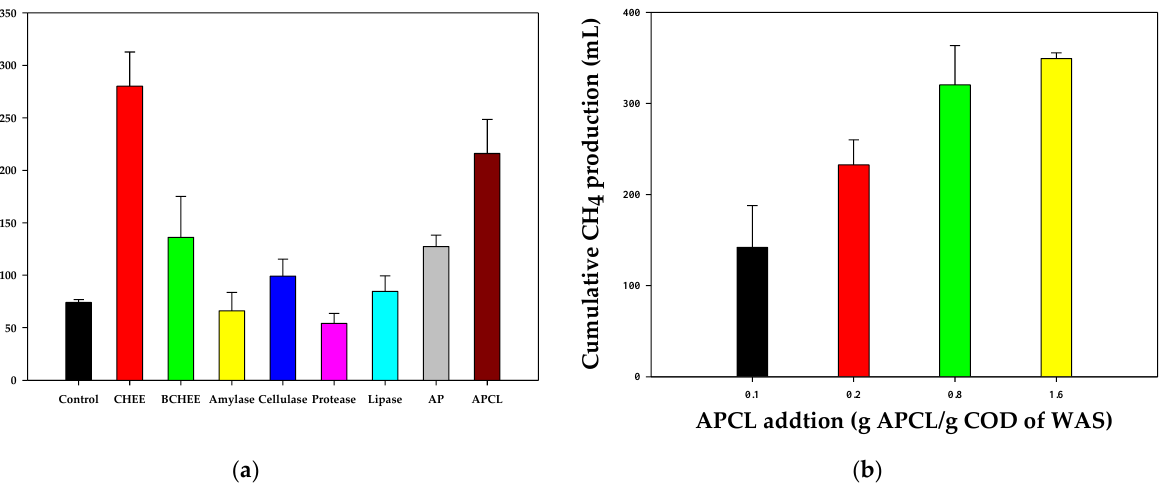
Figure 1. Cumulative CH 4 production from ( a ) batch test I and ( b ) batch test II of waste activated sludge pretreated with different types of enzymes. Table 1. Effect of enzymatic pretreatments using crude hydrolytic extracellular enzyme and com- mercial enzyme on batch test I of waste activated sludge for CH 4 production.